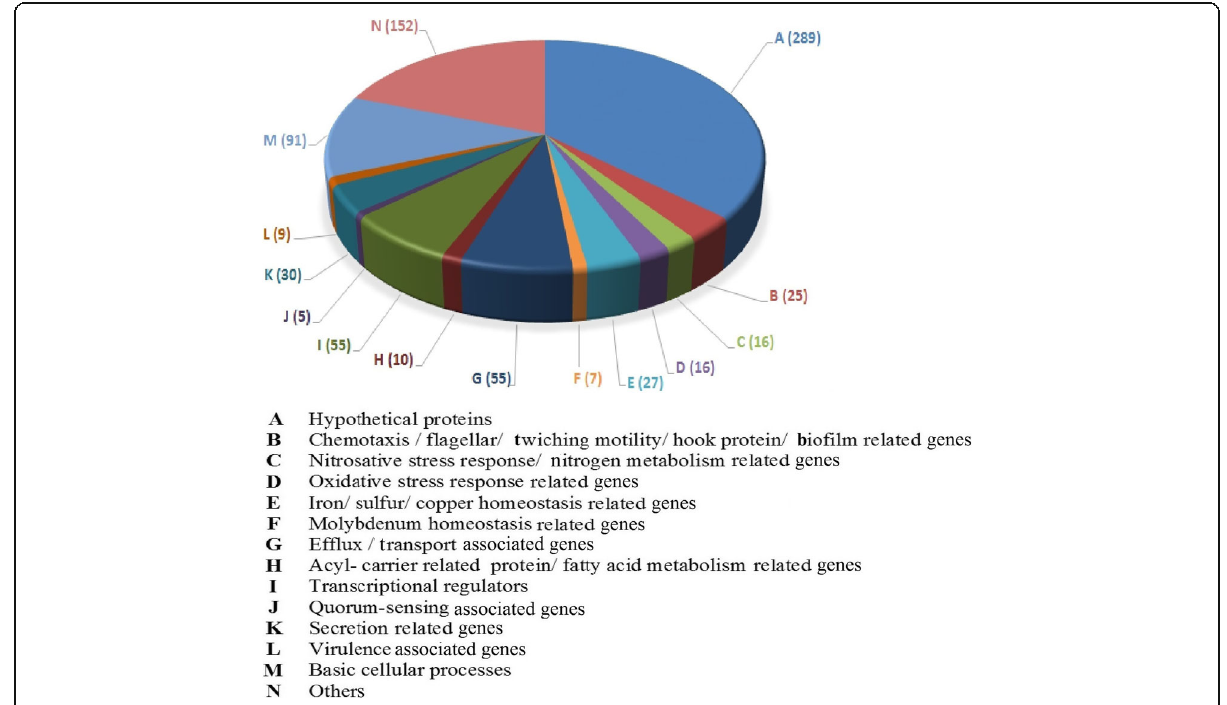
Fig. 3 Function-wise categorization of the significantly differentially expressed genes in Panchvalkal -treated P.